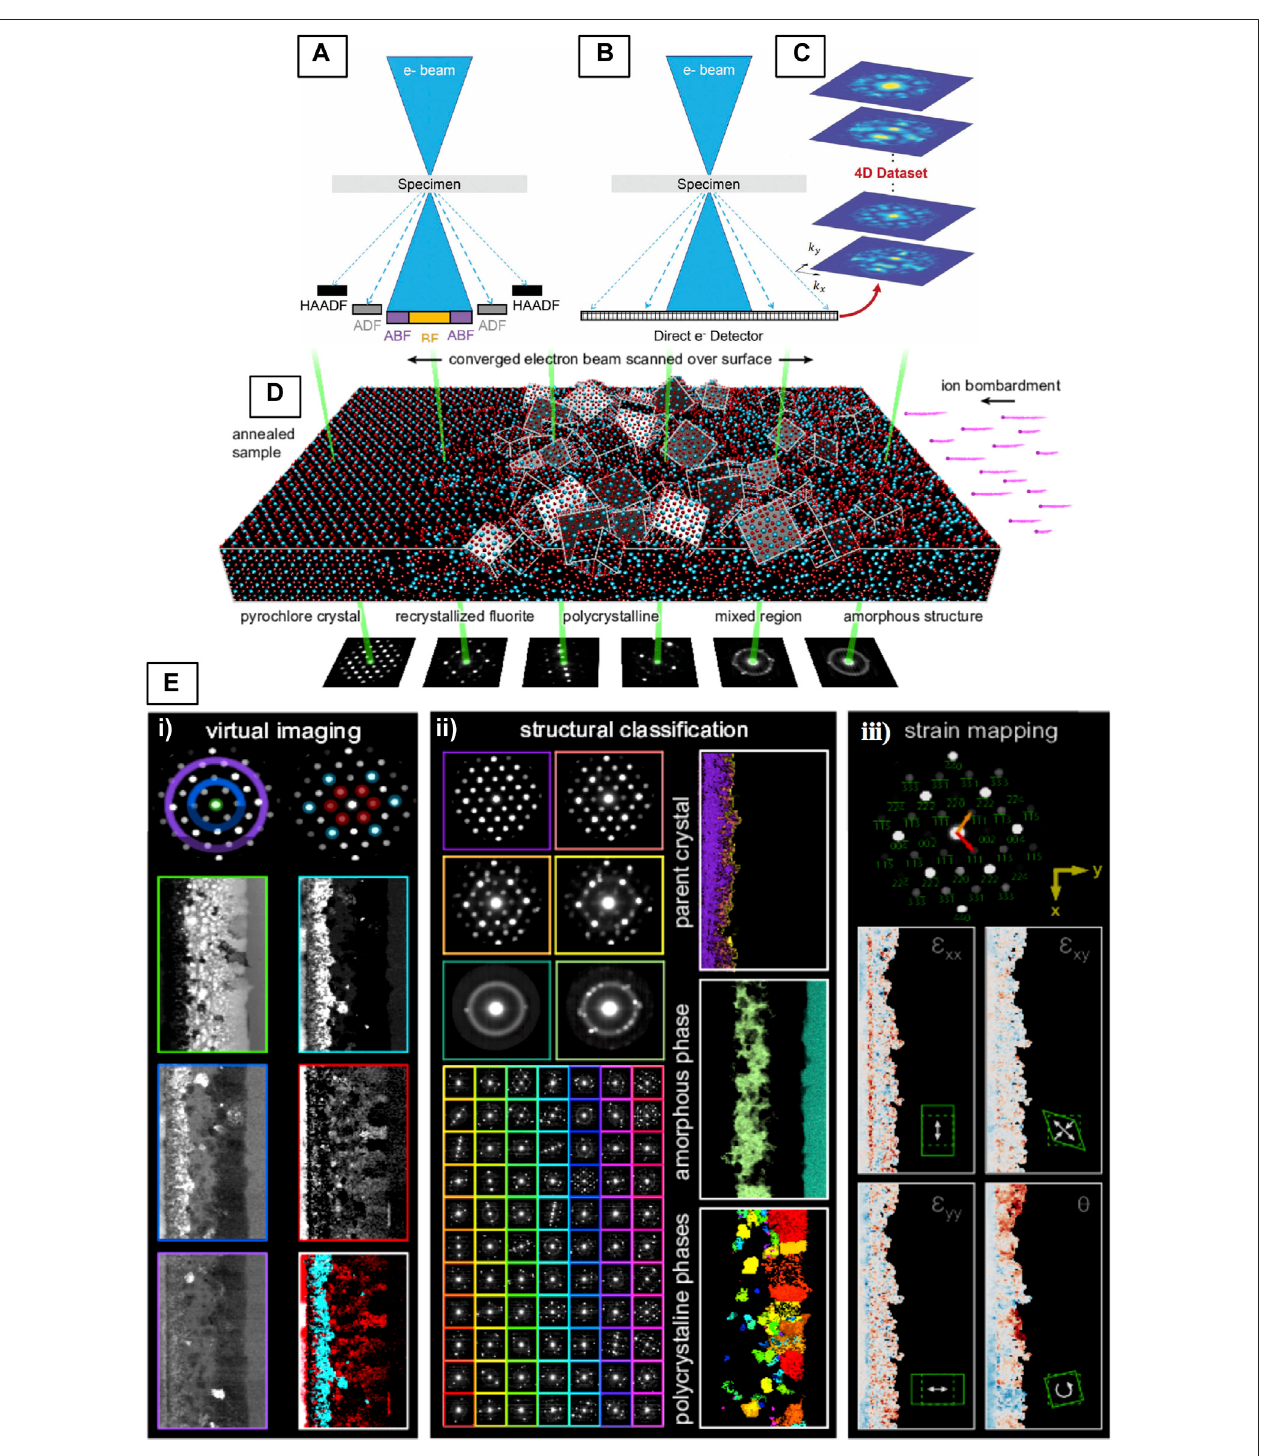
FIGURE 12 | (A – C) Illustration of conventional and 4D-STEM and (D,E) 4D-STEM experimental geometry, and multimodal data analysis with py4DSTEM. (A) In conventional STEM, signal is integrated over different angular regions of the diffraction plane. (B) In 4D STEM, an entire 2D CBED pattern is recorded at each probe position of a 2D-STEM raster, resulting in a (C) 4D dataset, Reproduced from (Levin et al., 2020b). (D) The experimental setup showing a pyrochlore-structured Gd 2 Ti 2 O 7 (GTO) sample that was irradiated and subsequently annealed showing gradient in structure from fully-ordered to amorphous (Savitzky et al., 2021). (E) Examples of various types of measurements that can be made in post-processing from the 4D-STEM dataset acquired in (D) . Reproduced from reference (Savitzky et al.,